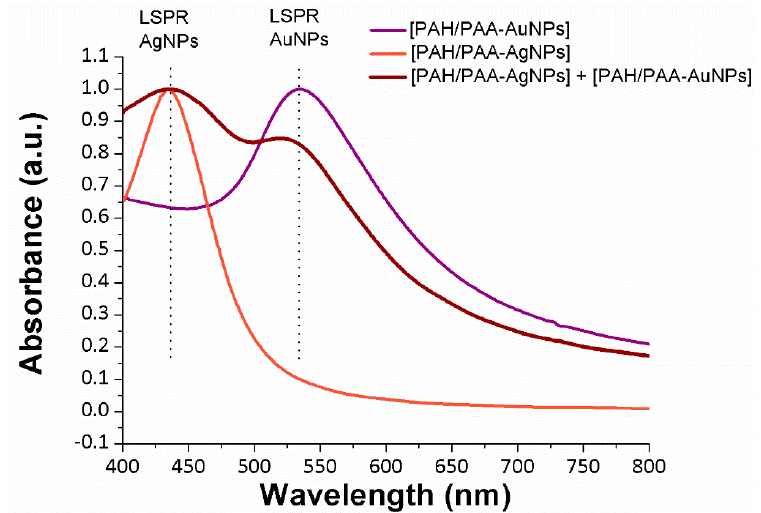
Figure 3. UV-Vis spectra changes of the LbL films based on the immobilization of metallic AgNPs (orange coloration), AuNPs (violet coloration) and mixture of both AgNPs and AuNPs (red-wine coloration), respectively.